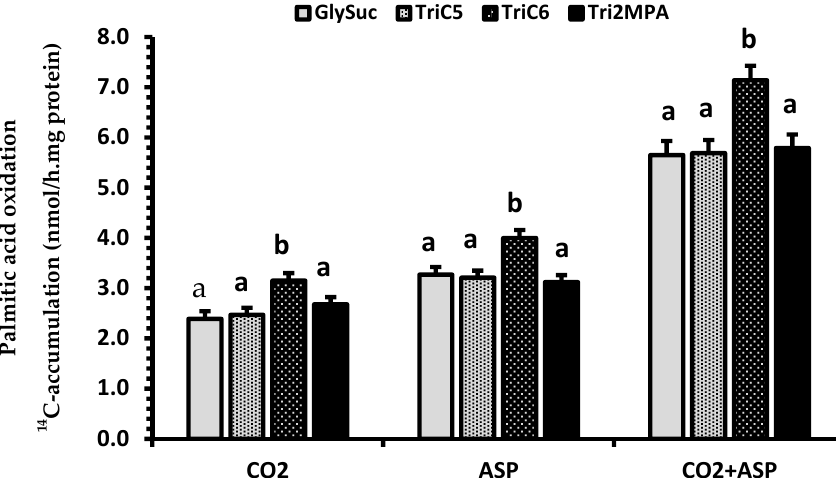
Figure 2. The main effect of dietary treatments on [1- 14 C]-palmitic acid oxidation. GlySuc (diet supplement with glycerol and succinate), TriC5 (triglyceride of valerate), TriC6 (triglyceride of hexanoate), and Tri2MPA (triglyceride of 2MPA). Data (Lsmeans ± SEM) are 14 C-accumulations in CO 2 , acid soluble products (ASP) and CO 2 + ASP ( n = 16). a,b Treatments for CO 2 , ASP, and CO 2 + ASP with different superscripts differ ( p < 0.05).